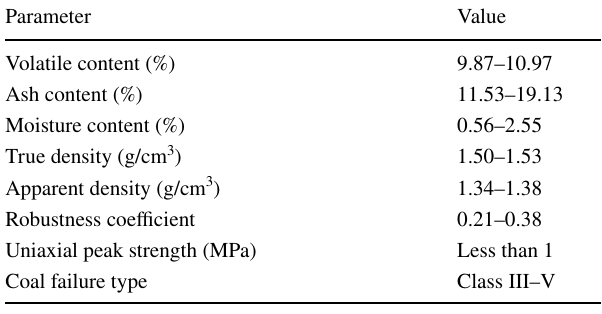
Table 1 Industrial analysis parameters of pulverized